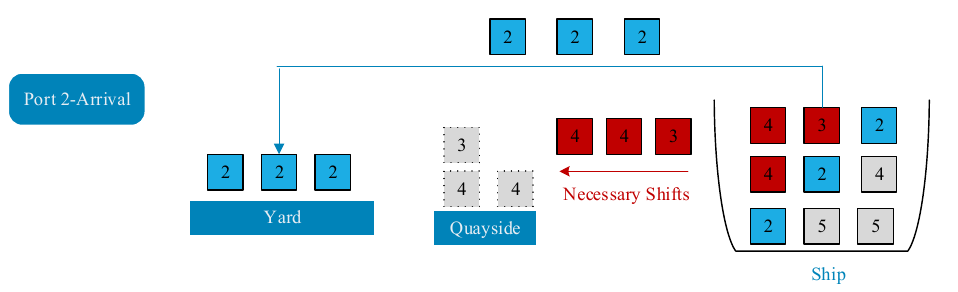
Figure 3. Example of voluntary container shifts.